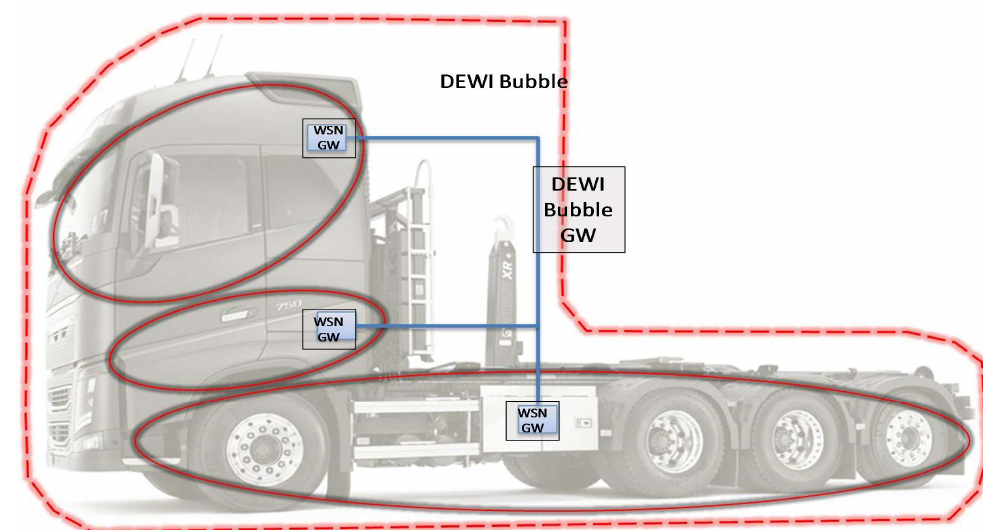
Figure 19. Mapping UC3.8 to the layered model of the DEWI HLA.